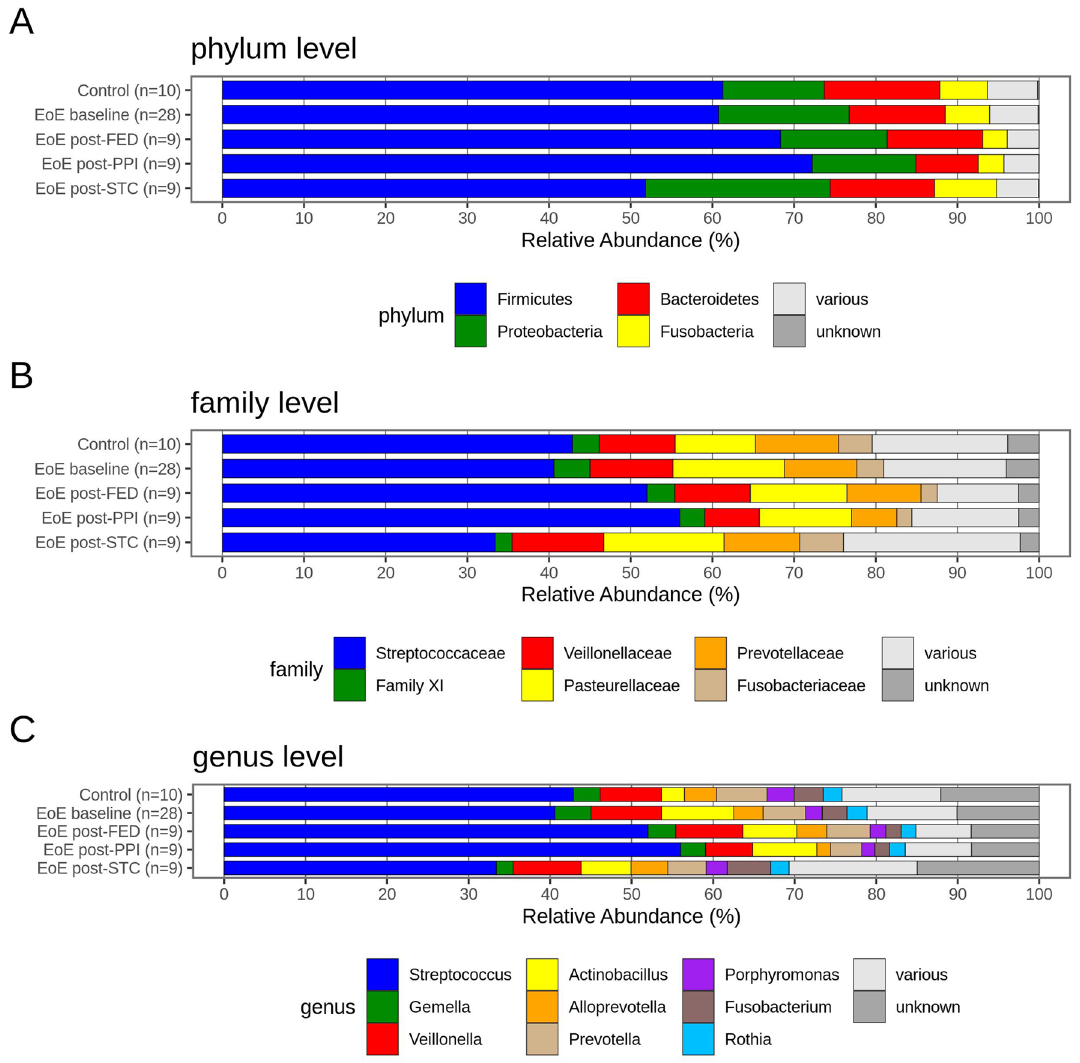
Figure 4. Relative bacterial abundance of the most represented phyla ( A ), families ( B ) and genera ( C ) in oesophageal biopsies classified within the following groups: control subjects, baseline EoE patients, and EoE patients according to treatment followed to achieve EoE remission.